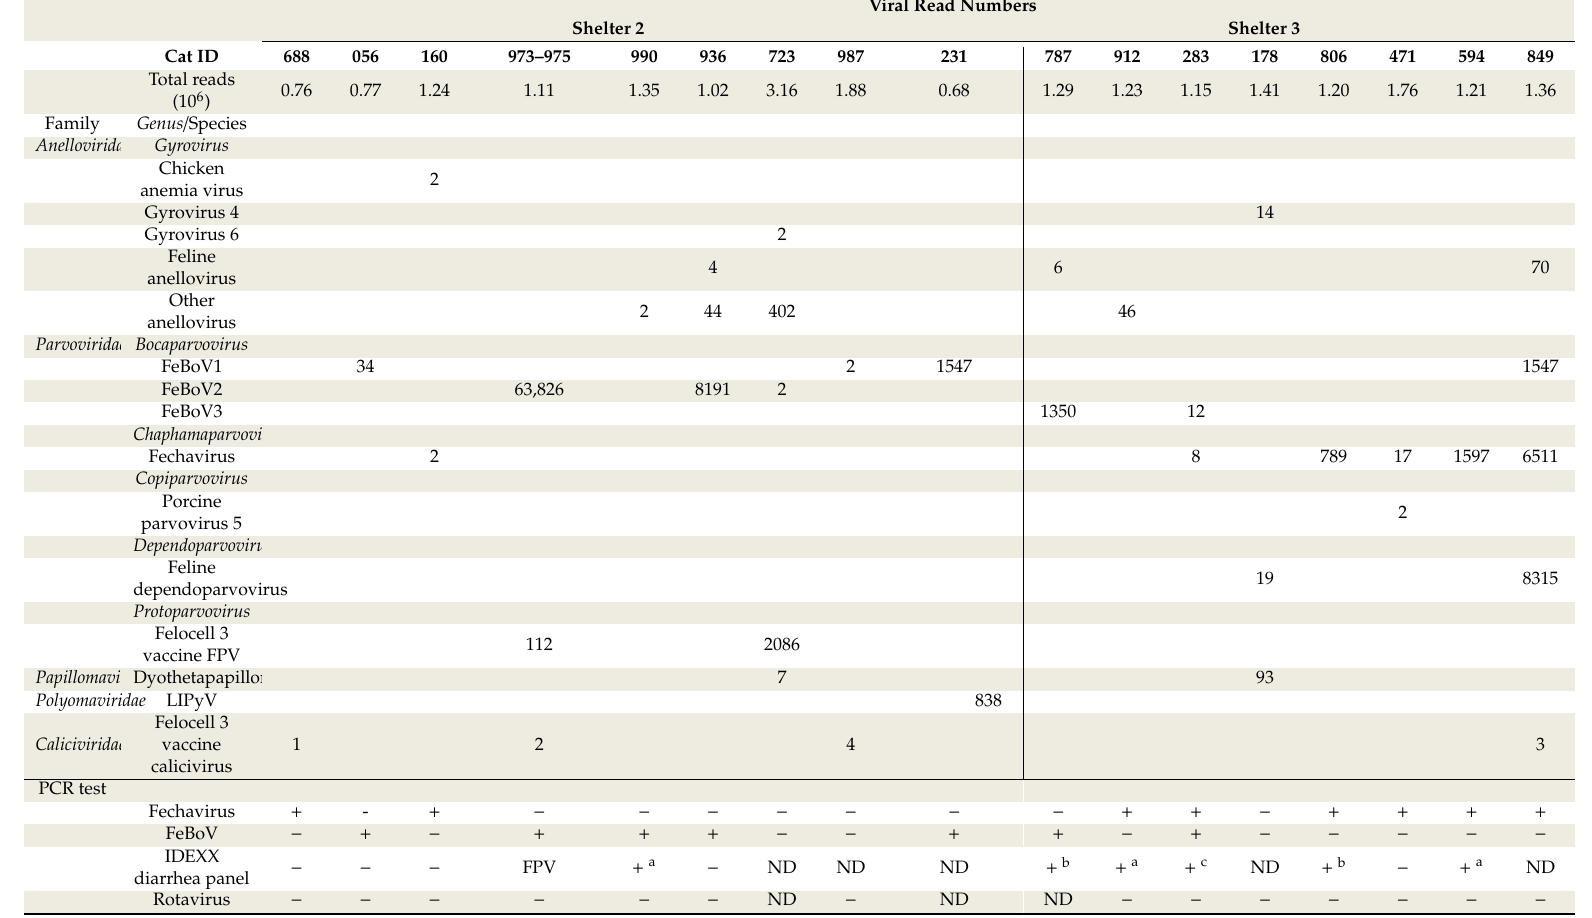
Table 3. Metagenomic results and PCR test of each case